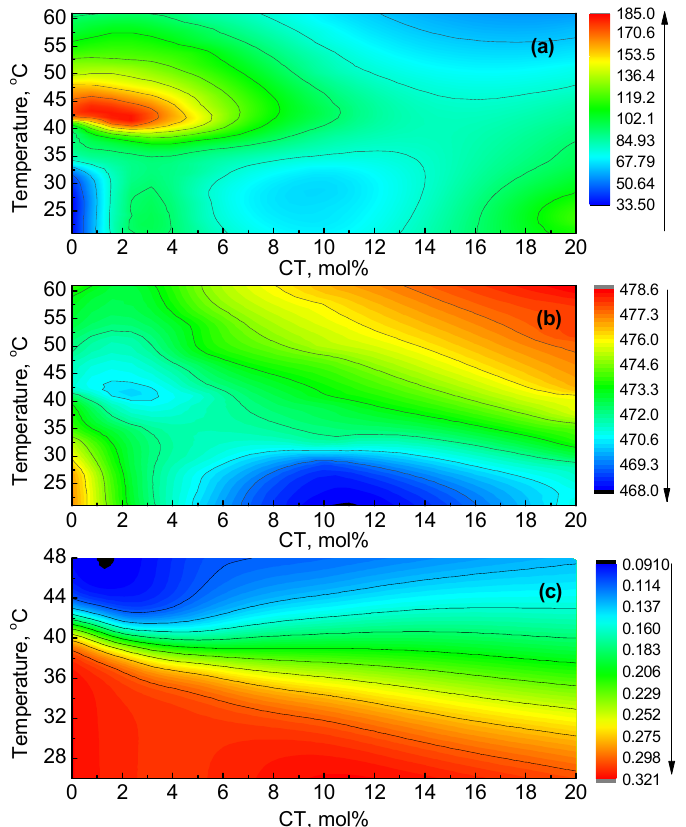
Figure 7. Contour plots of ANS and DPH; ( a ) packing density, using ANS FI max data from Figure 1a; ( b ) hydrophobicity, using ANS λ max data from Figure 2a; ( c ) order–disorder, using data from DPH emission anisotropy given in Figure 3a.